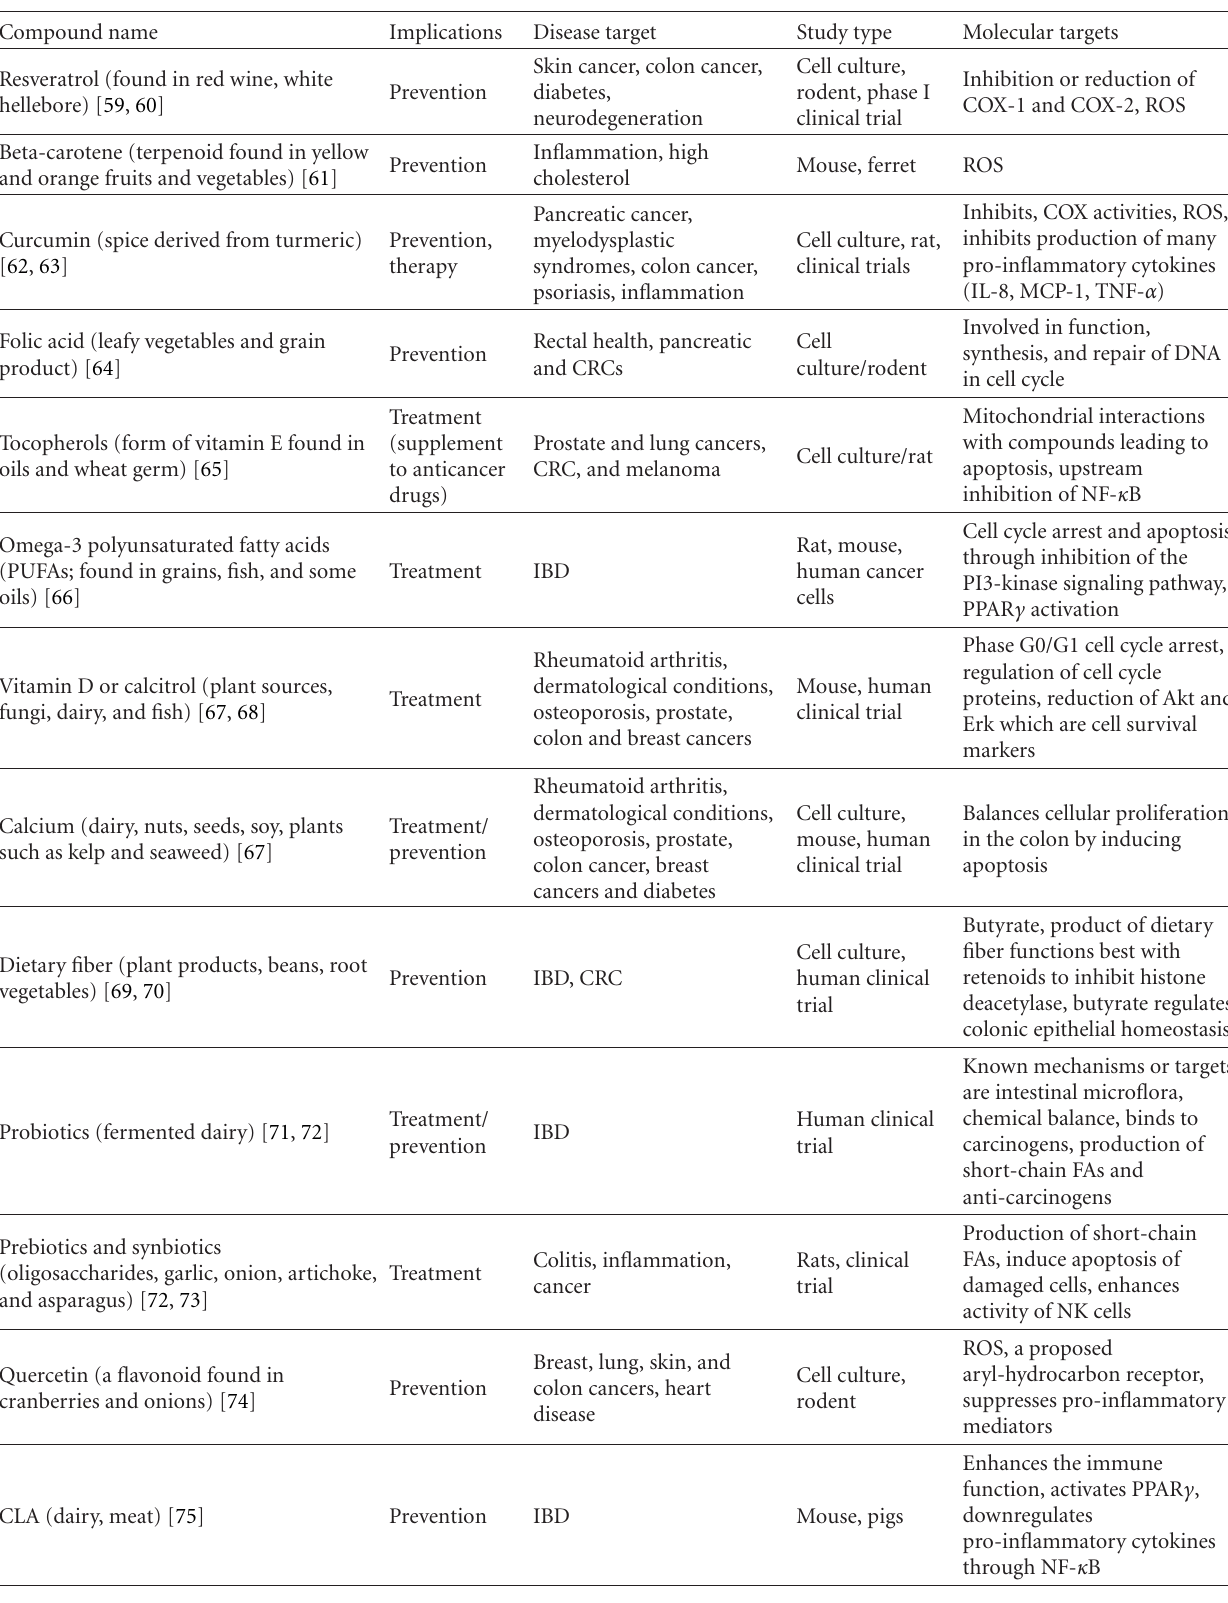
Table 1: Natural compounds with therapeutic action against